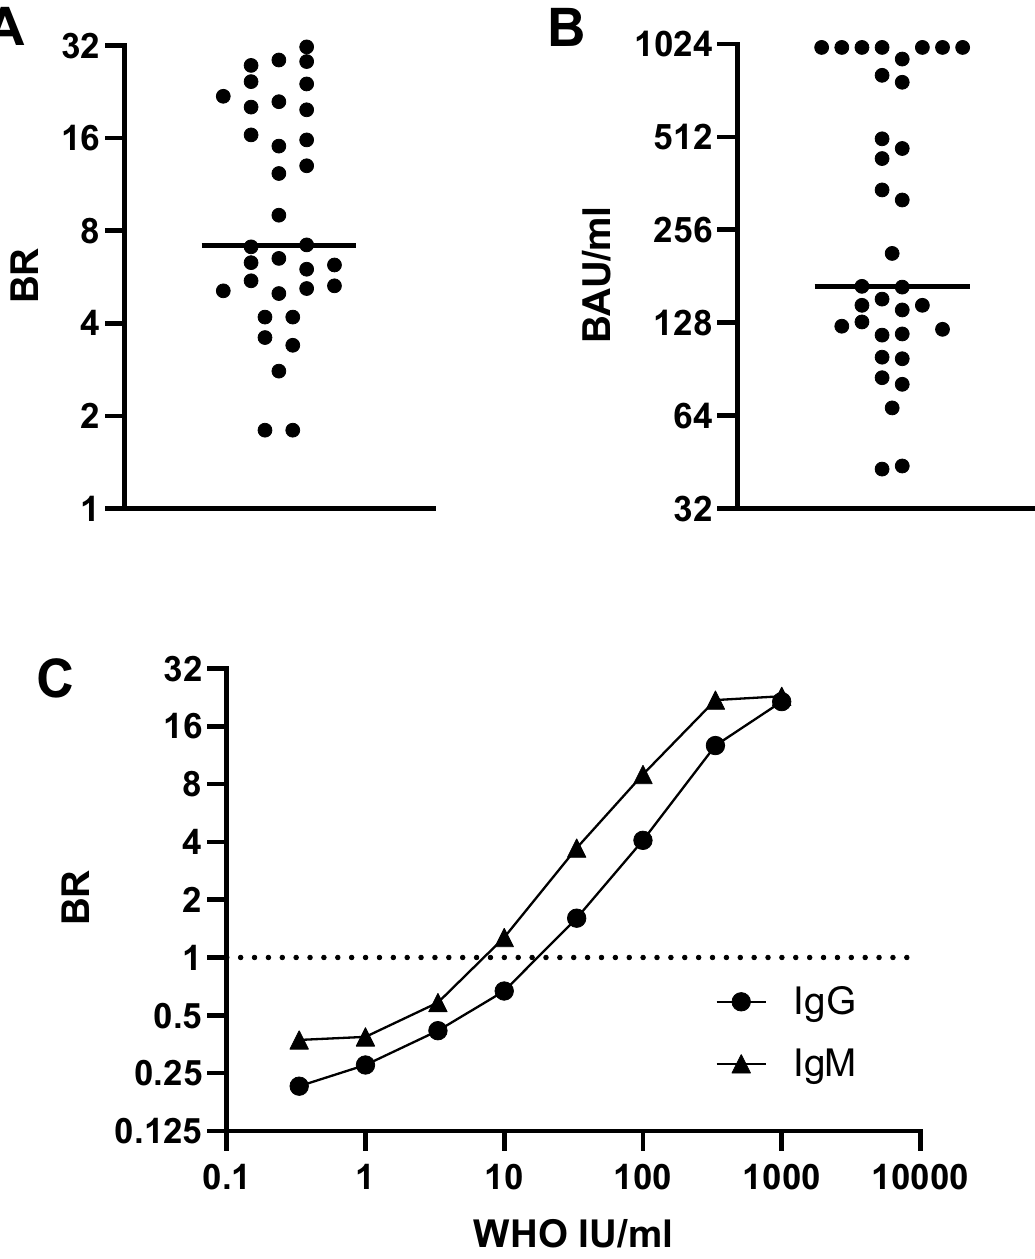
Figure 7. Measuring post-vaccine antibody responses using DBS sampling and the WHO International standard (NIBSC 20/136). DBS eluates obtained from 34 individuals who were ≥ 14 days post-immunisation are all reactive, demonstrating effectiveness at detecting vaccine-induced antibody responses. Binding Ratios ( A ) and inferred WHO International Units ( B ) from S1 IgG capture are displayed on a Log 2 scale, the line is the median, BR of 1 and WHO32 IU are the cut off values. ( C ) The relationship between S1 IgM and IgG capture Binding Ratios and WHO IU/ml, with BR displayed on Log 2 scale and IU/ml on a Log 10 scale. IgG IU/ml are shown with a circle and IgM IU/ml are shown with a